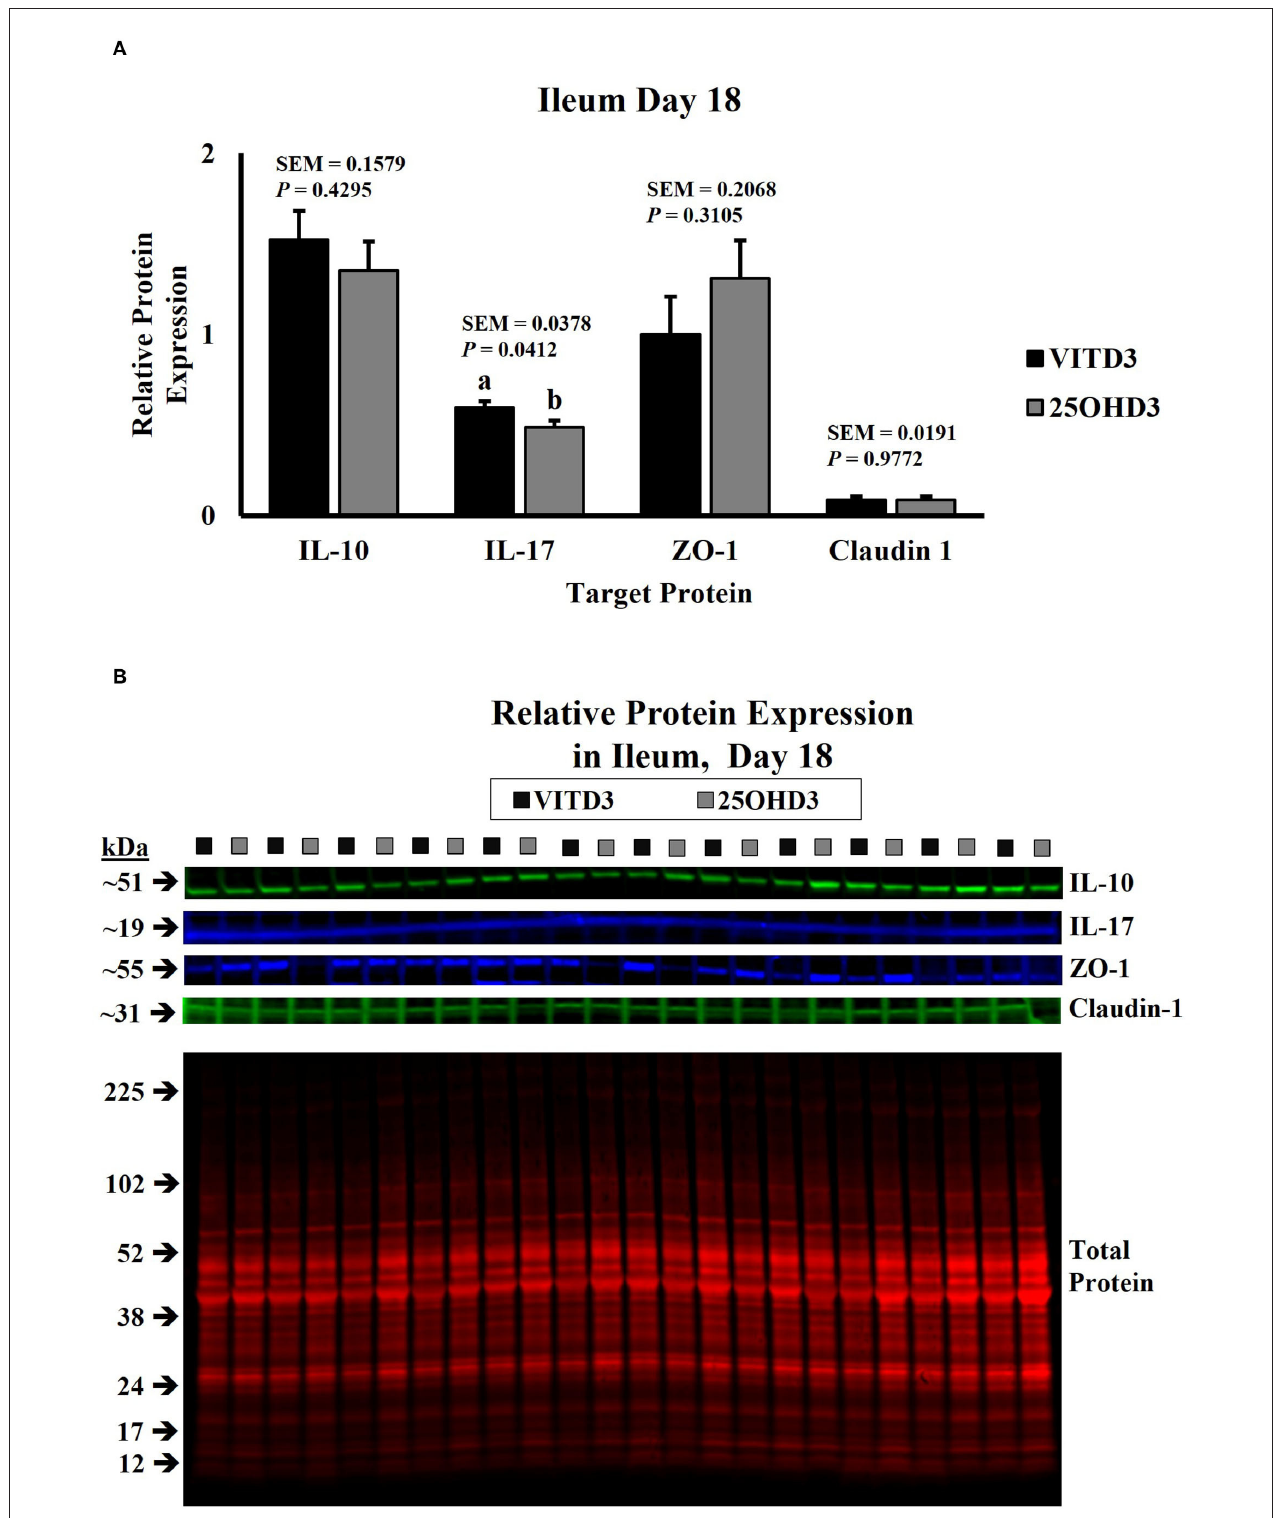
FIGURE 1 | Effect of dietary 25-hydroxycholecalciferol supplementation on 18-day-old broiler chicken ileal protein abundance. In total, 24 birds were sampled on each sampling day (n = 12 birds of each treatment). Dietary treatments: VITD 3 = 5,000 IU of vitamin D 3 per kg of broiler chicken feed; 25 OHD 3 = 2,760 IU of 25-hydroxycholecalciferol + 2,240 of vitamin D 3 per kg of broiler chicken feed. Protein expression was measured using quantitative, fluorescent Western Blot relative to total protein. (A) IL-10, IL-17, ZO-1, and Claudin-1 protein abundance. (B) Day 18 representative fluorescent Western Blot. Abundance of IL-17 was grater for VITD3-fed birds. a,b Bars with different superscripts differ at P ≤ 0.05.